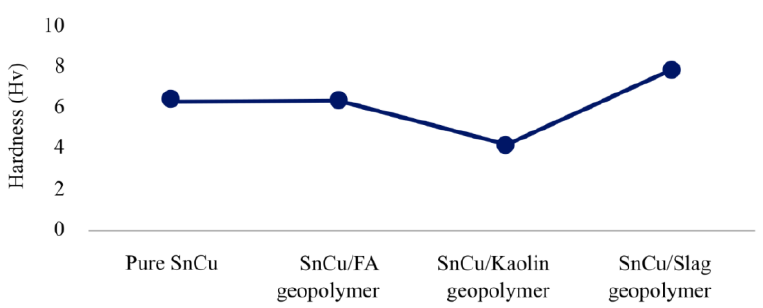
Figure 7. Different compositions of composite solder hardness value [133].